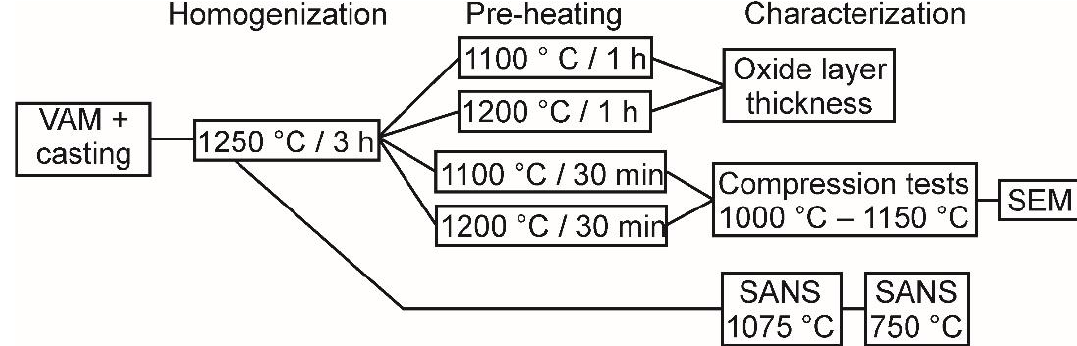
Figure 1. Schematic overview of the experimental methods and their sequence.